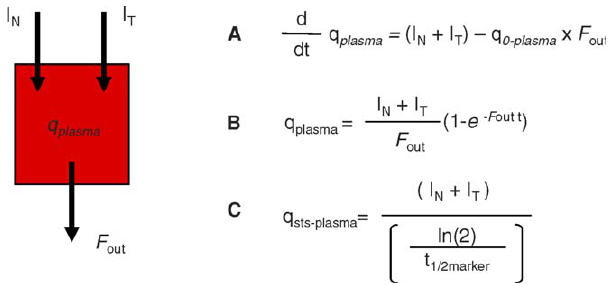
Table 1. General Parameters of the Tumor Biomarker